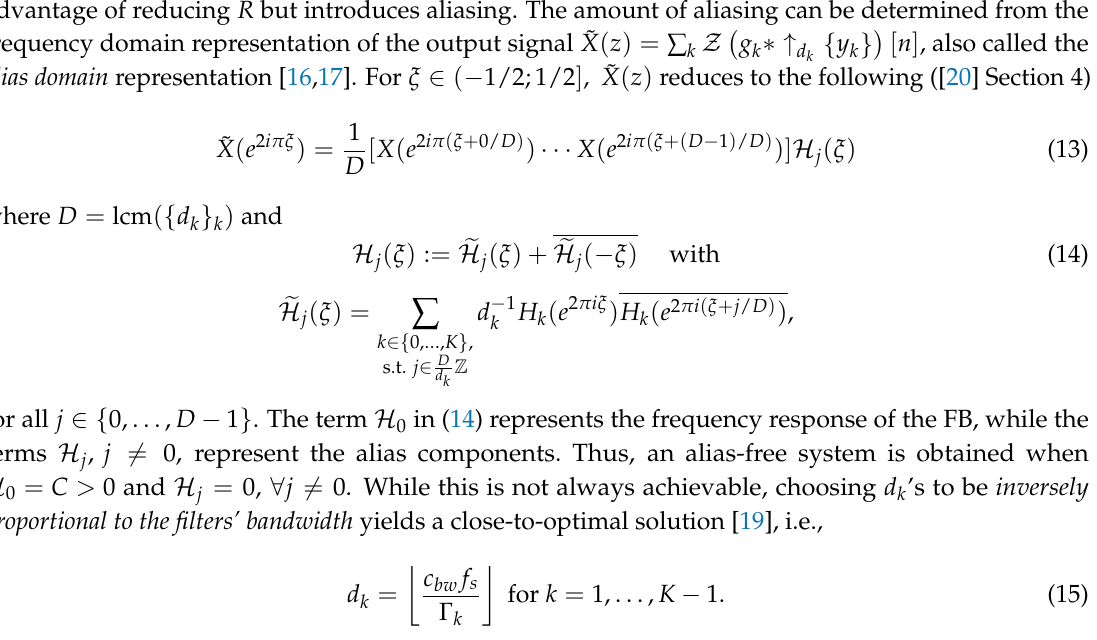
( r ) ( ξ ) (dashed line) of an 0